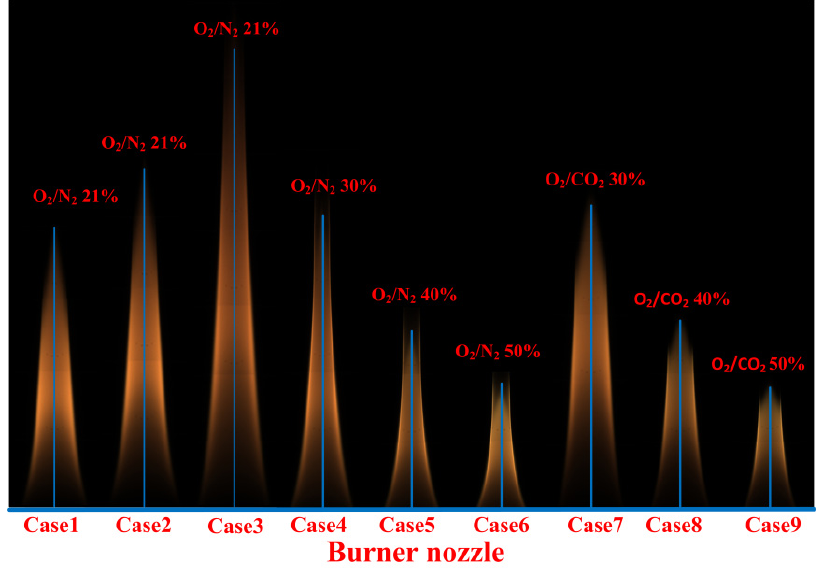
Figure 12. Color images of ethylene flames in pure air atmosphere, O 2 /N 2 , and O 2 /CO 2 oxygen-enhanced atmospheres.